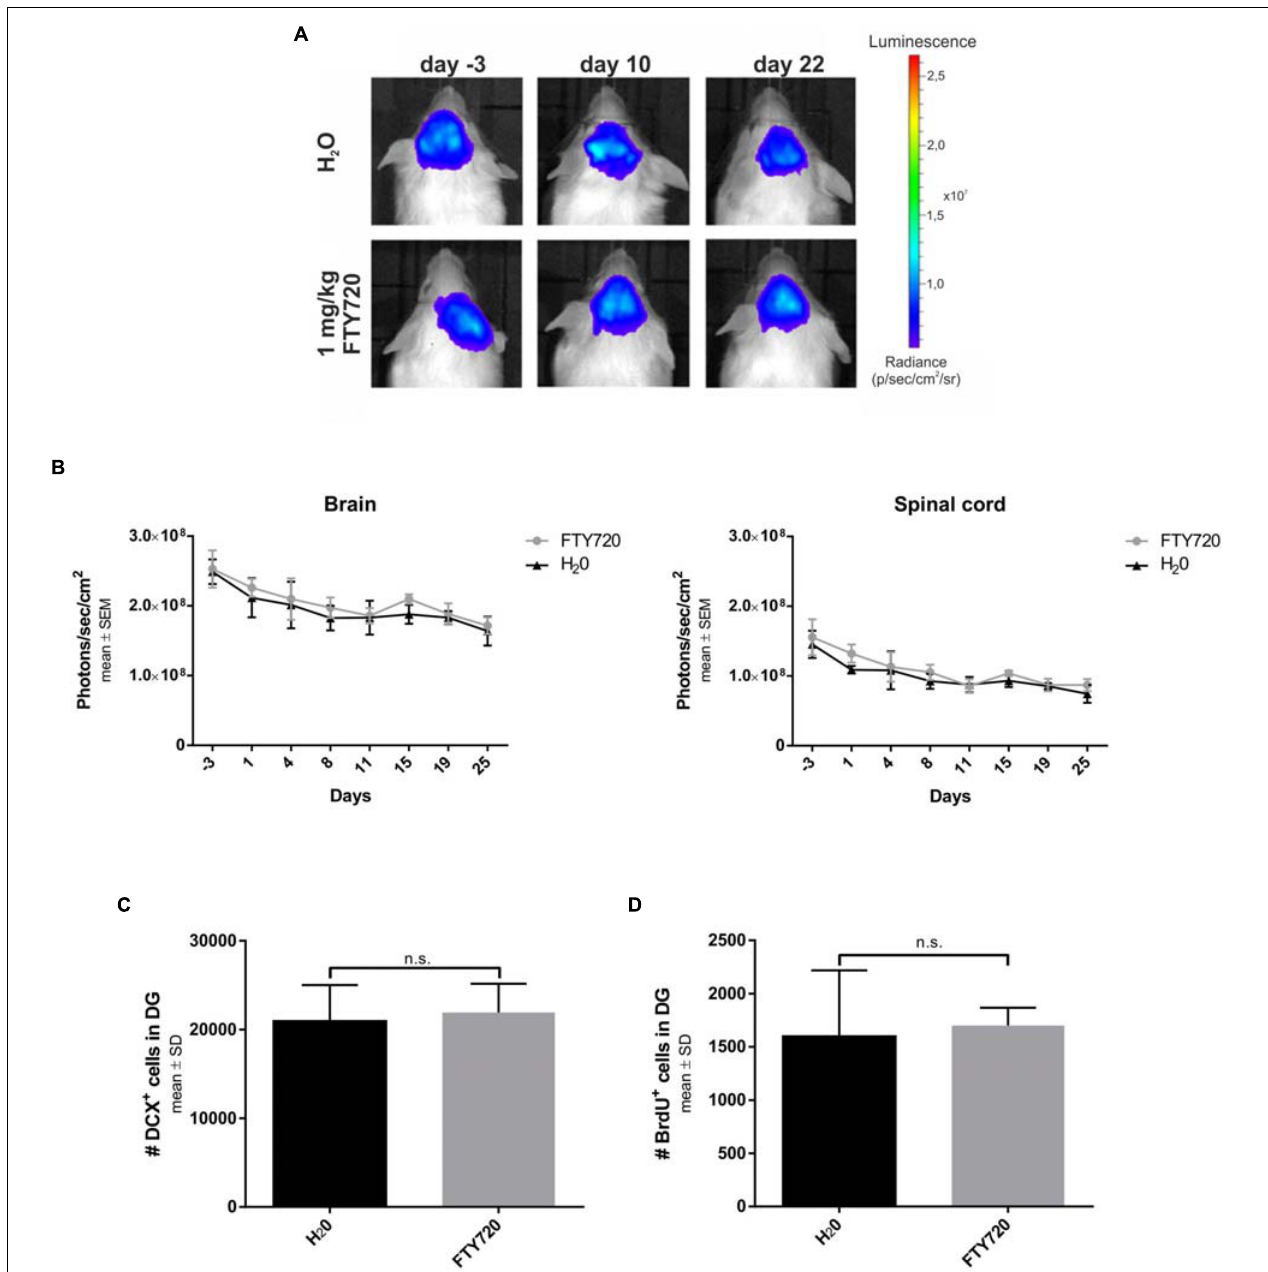
FIGURE 6 | Longitudinal evaluation of neurogenesis in naive mice treated with FTY720. Naive B6(Cg)-Tyrc-2J/J DCX-luc reporter mice were treated from day 0 to 28 with FTY720 1.0 mg/kg ( n = 5) or water ( n = 5) by oral gavage once per day. Treatment groups were sex- and age-matched and stratified according to their bioluminescence signal intensity at day − 3. (A,B) Doublecortin (DCX) signal intensity was evaluated by bioluminescence imaging of areas of interest (brain, spinal cord) twice per week. (C,D) After 28 days mice were perfused with PFA and consecutive sagittal brain slices examined by immunohistochemistry for DCX and bromodeoxyuridine (BrdU) in the dentate gyrus. Results are presented as mean ± SEM (B) and mean ± SD (C,D)